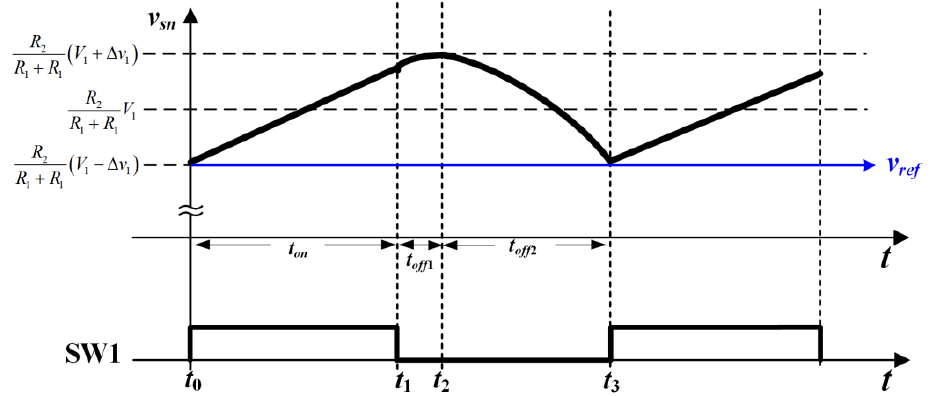
Figure 6. The enlarged waveform of the sensed output voltage.